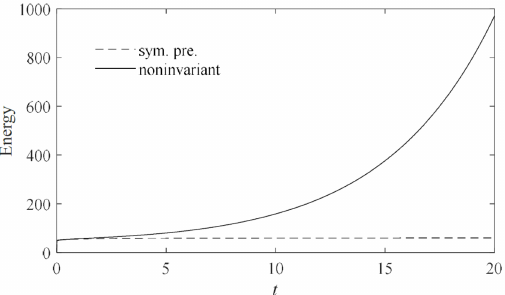
Figure 3. Energy for the symmetry preserving schemes (60) and the noninvariant (61) of Hamiltonian